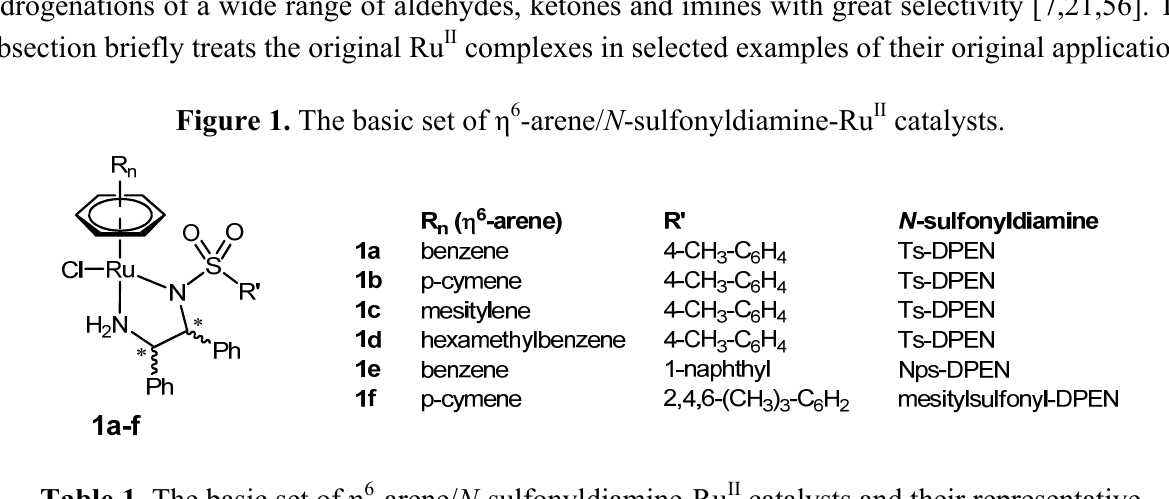
Table 1. The basic set of η 6 -arene/ N -sulfonyldiamine-Ru II catalysts and their representative